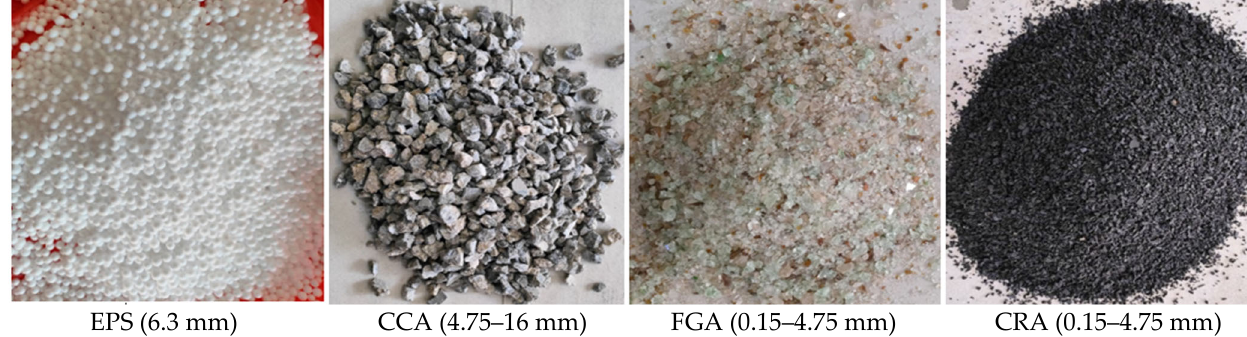
Figure 5. The types of recycled aggregates.